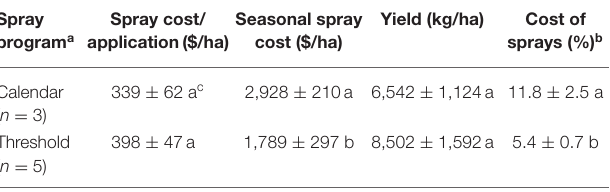
TABLE 1 | Costs for spray program, production of coffee cherry, and relative cost needed to pay for insecticide applications, based on surveys in eight coffee farms in Kona and Ka’u districts, Hawaii, USA (2016/17